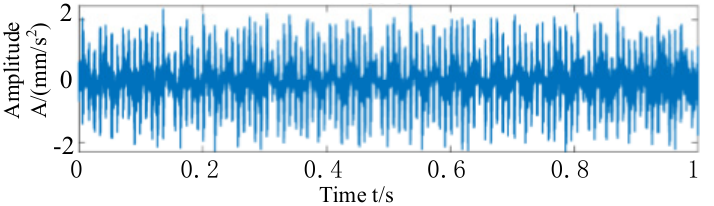
Figure 18. Time-domain waveform of the harmonic components extracted by the adapOMP.